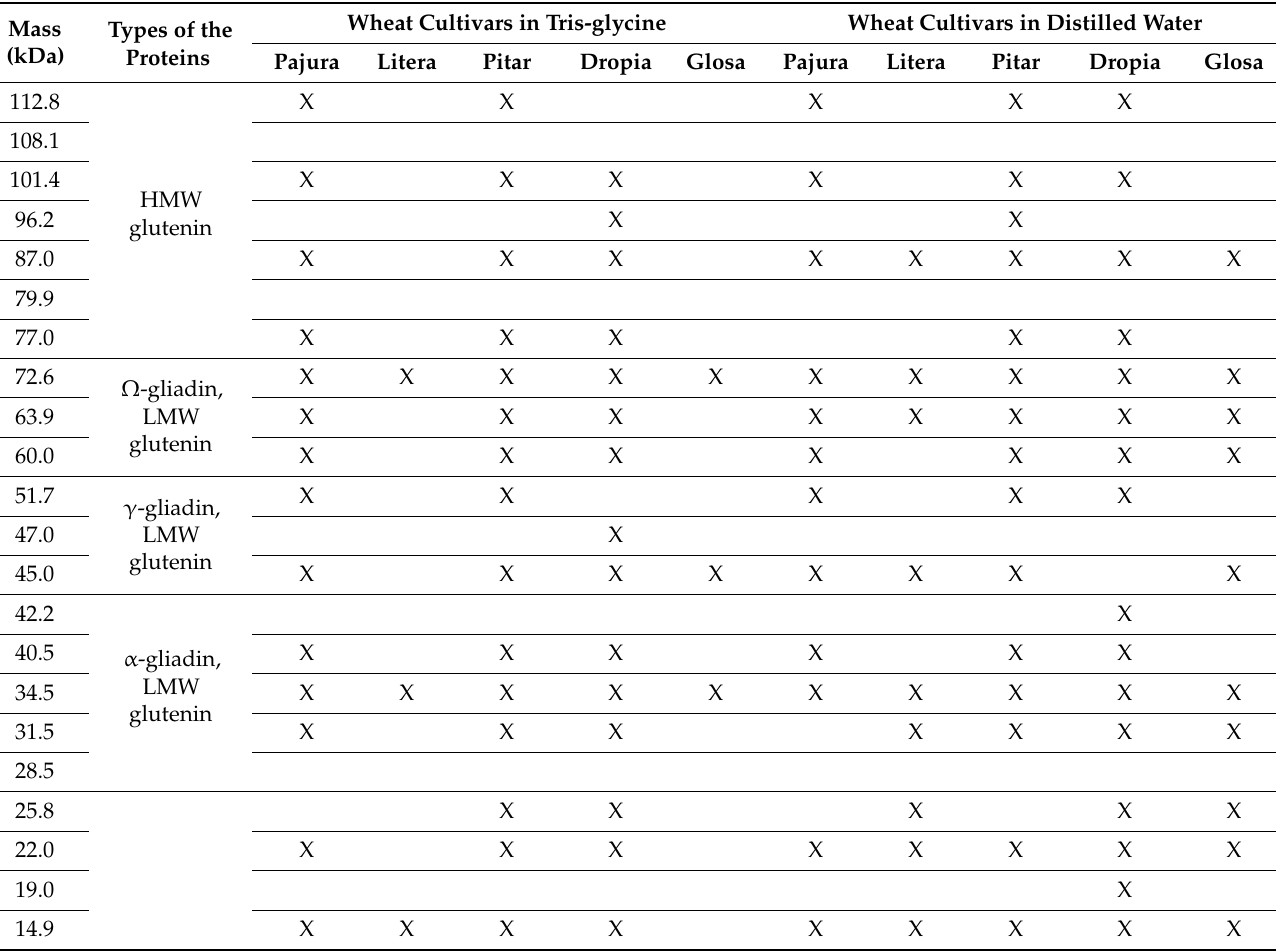
Table 9. Identification of proteins from the colored sample strips using Thermo Scientific Pierce Silver Stain ® (Wheat cultivars).